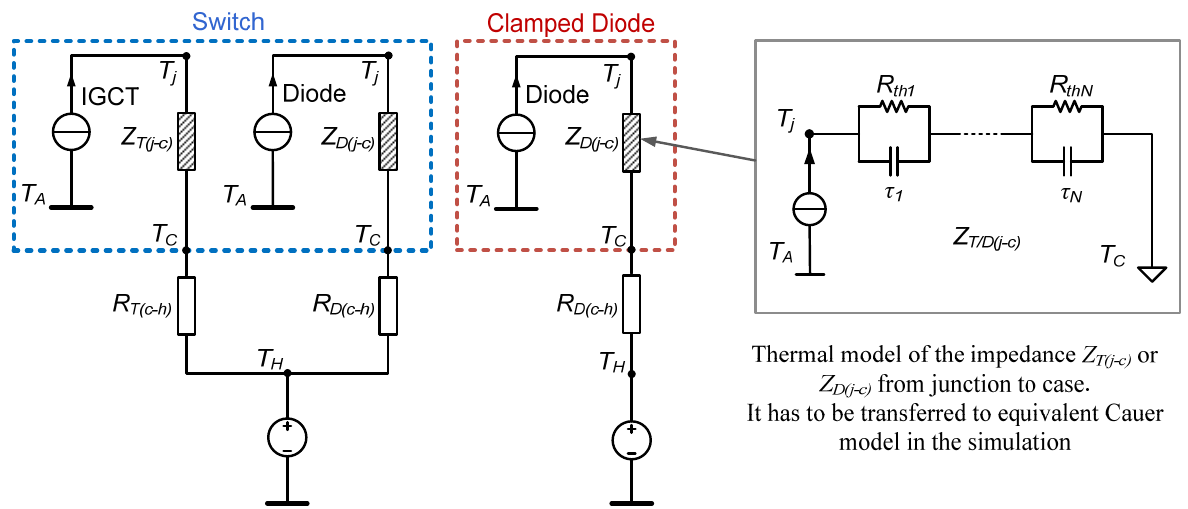
Figure 8. Thermal model for the analysis and simulation of 3L-NPC